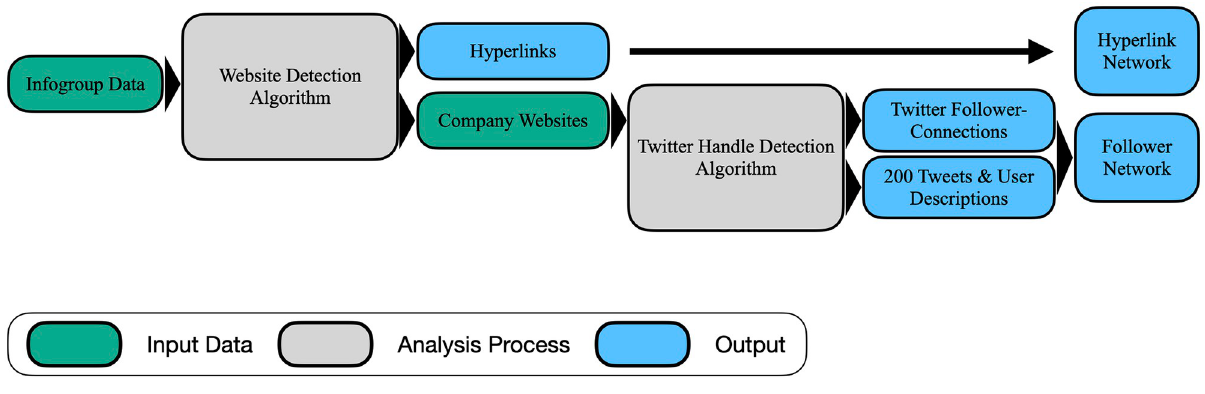
Fig 1. Data acquisition and